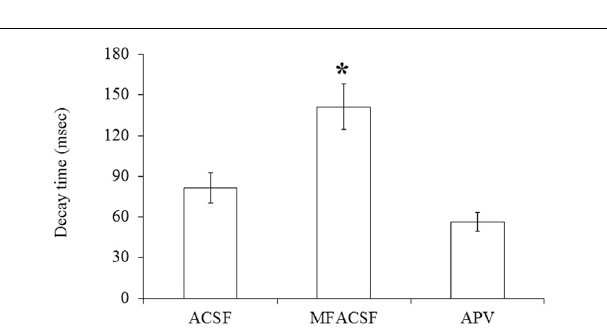
FIGURE 5 | The PSP decay time of POA neurons connected to the OB under the different perfusions (normal ACSF, Mg 2 + free ACSF (MFACSF) and APV). Error bars denote s.e.m. Asterisks ( ∗ ) statistical significance ( P < 0 . 05) between